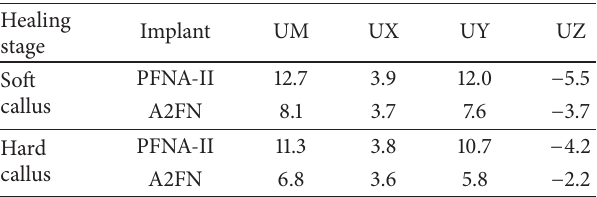
Table 4: The maximum displacements of the proximal femur in two healing stages